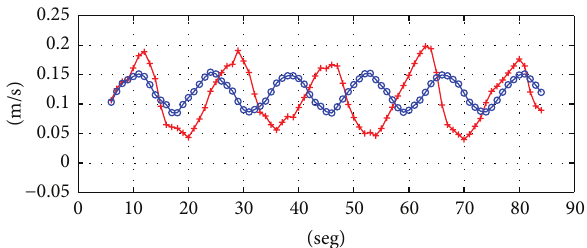
Figure 9: Comparing measurement data (+) and simulated data ( ∘ ) of the velocity component 𝑈 on the viewer 𝑉 1 obtained using the ml-03 model.